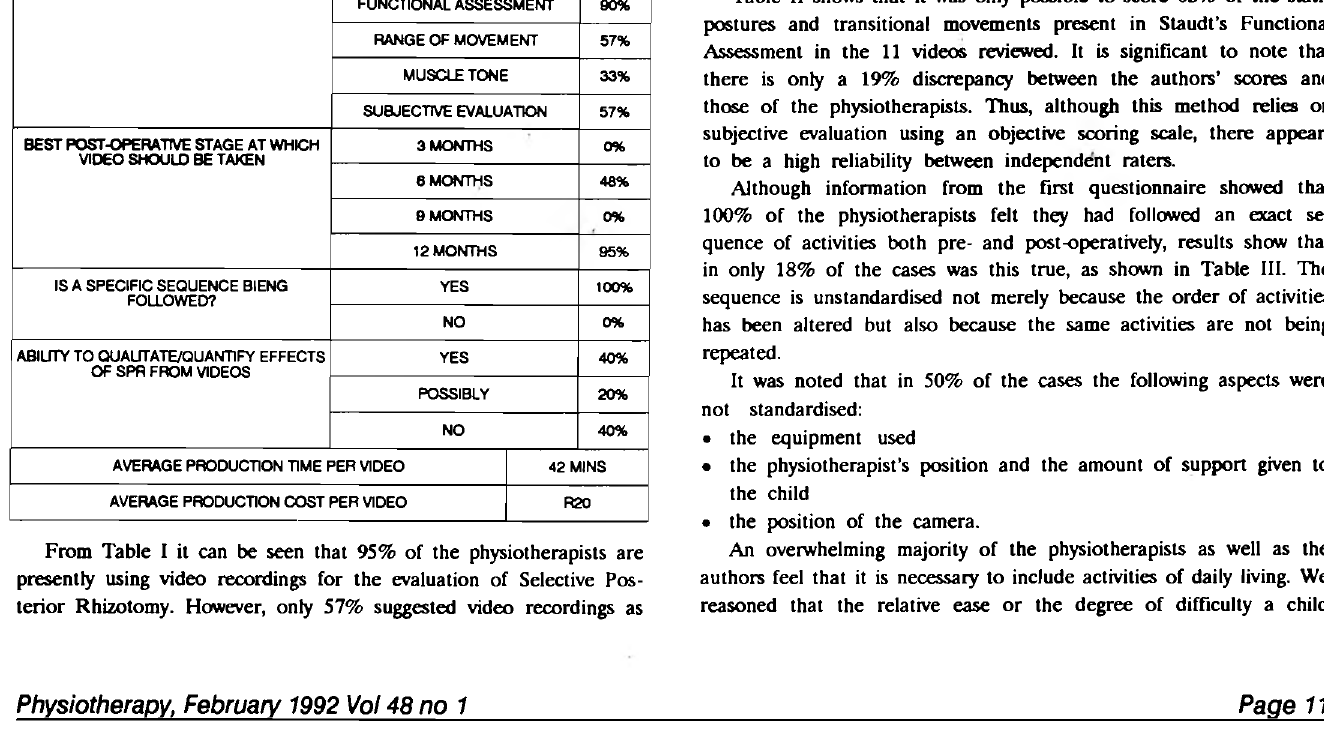
Table I: The results obtained from questionnaire A USING VIDEO RECORDINGS FOR EVALUATION? PREFERRED METHODS OF EVALUATING THE SUCCESS OF SPR